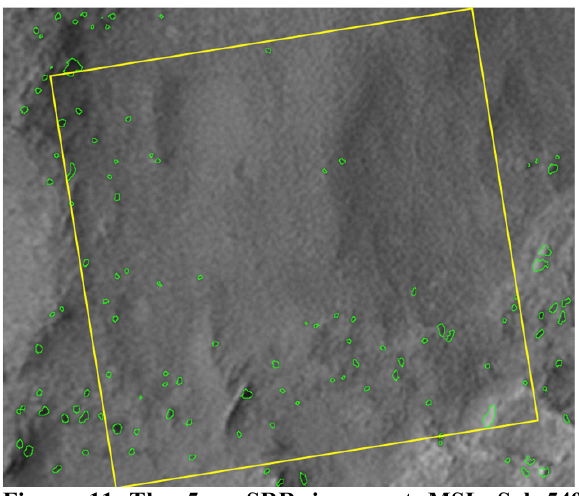
Figure 11 The 5cm SRR image at MSL Sol 549 showing automatically detected rocks (green) and the valid ROI (yellow) from Navcam vertical projected mosaic at the same area.